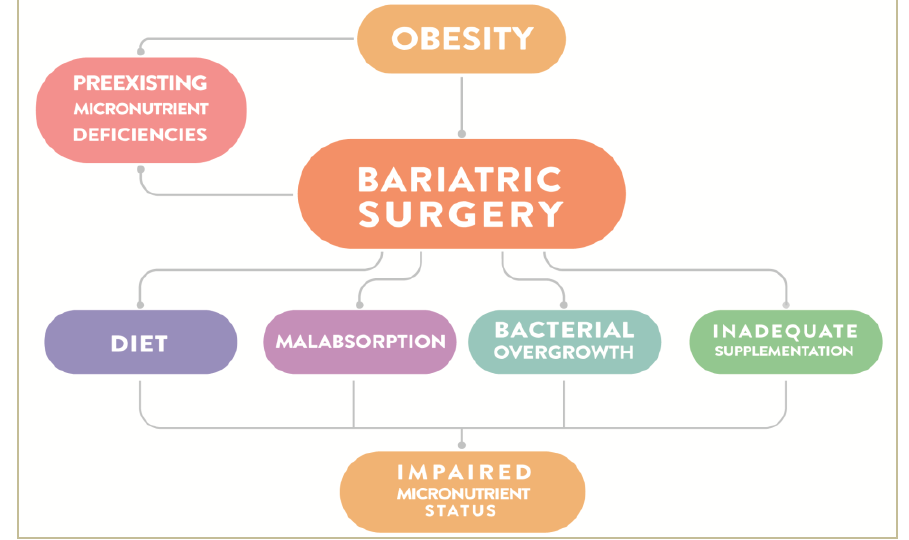
Figure 3. Schematic diagram illustrating the main factors responsible for micronutrient deficiencies in bariatric patients after surgery. Baseline nutritional shortage may worsen postoperative deficiencies. Changes in eating behavior, decreased absorptive capacity, small intestine bacterial overgrowth, and poor compliance to postoperative dietary optimization and nutritional supplementation also contribute to the state of micronutrient deficiency following BS.